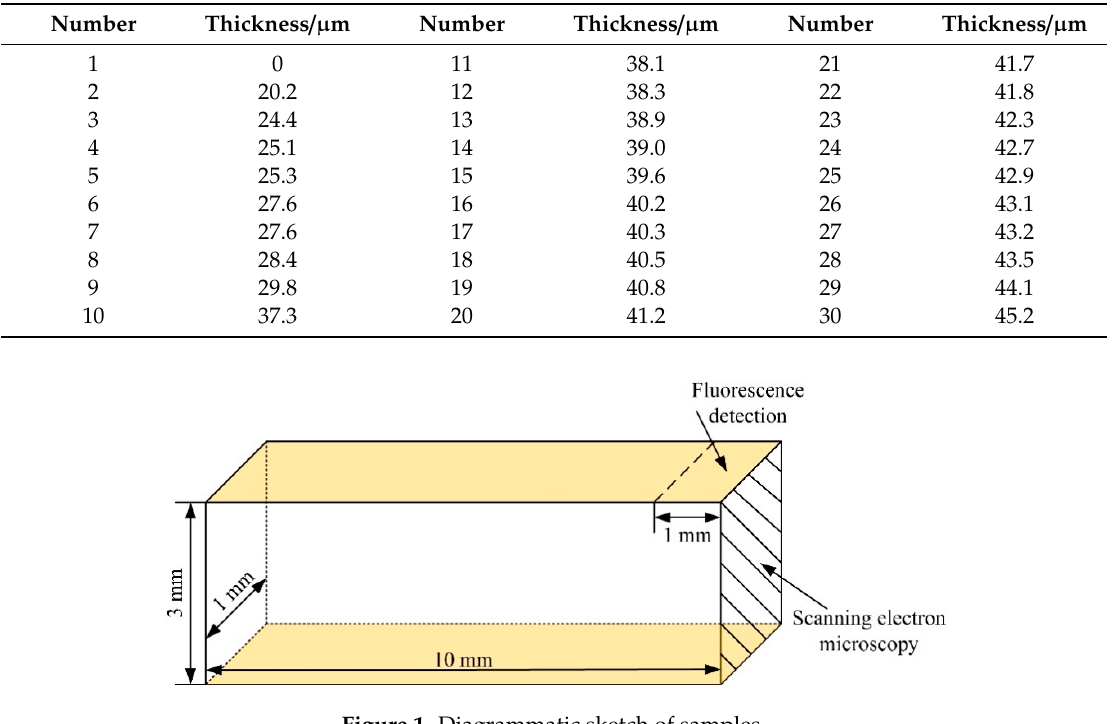
Figure 1. Diagrammatic sketch of samples.